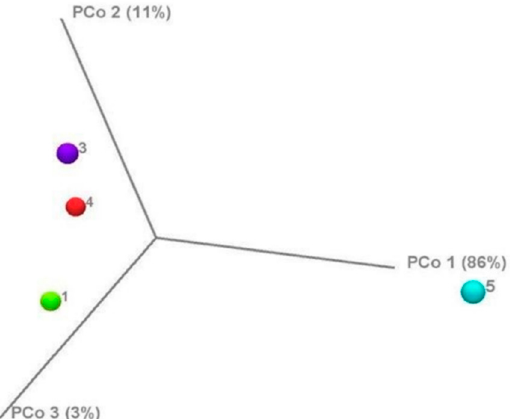
Figure 4. Principal component analysis (PCoA) showing the differences between the untreated (con- trol) and antibiotic-treated soil samples determined using the weighted UniFrac diversity metric. Each colored symbol corresponds with an individual sample (1: untreated soil sample (control), 3: soil treated with benzylpenicillin, 4: soil treated with oxytetracycline, and 5: soil treated with tylosin). The variation represented by each axis (PC1, PC2, or PC3) is shown in parentheses.